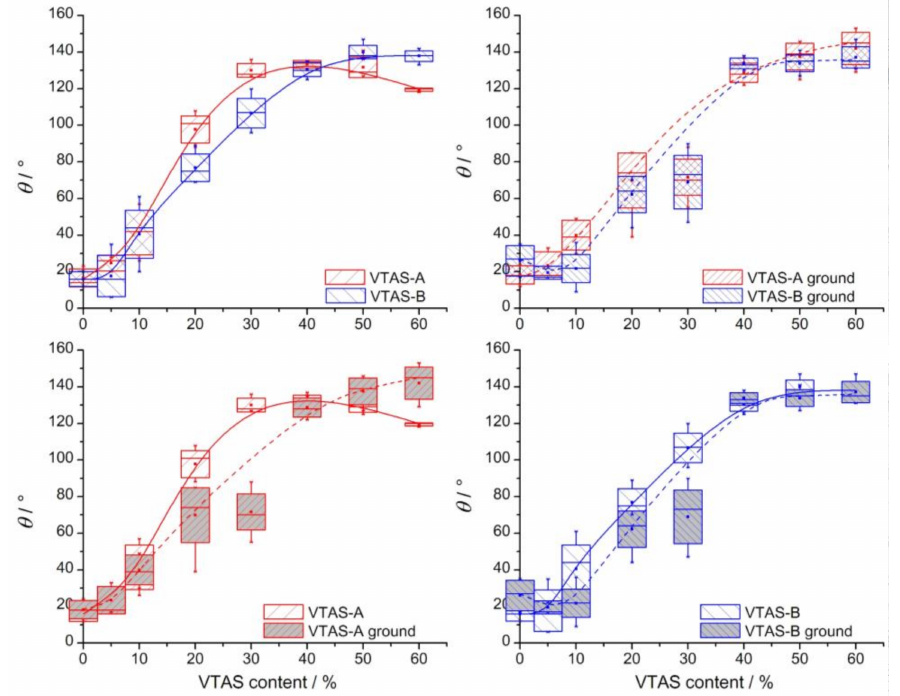
Figure 12. Box plot statistical representation of the advancing contact angles of VTAS samples, type A and B, both as-received and ground, in function of the vinyl content, grouped in pairs in order to facilitate